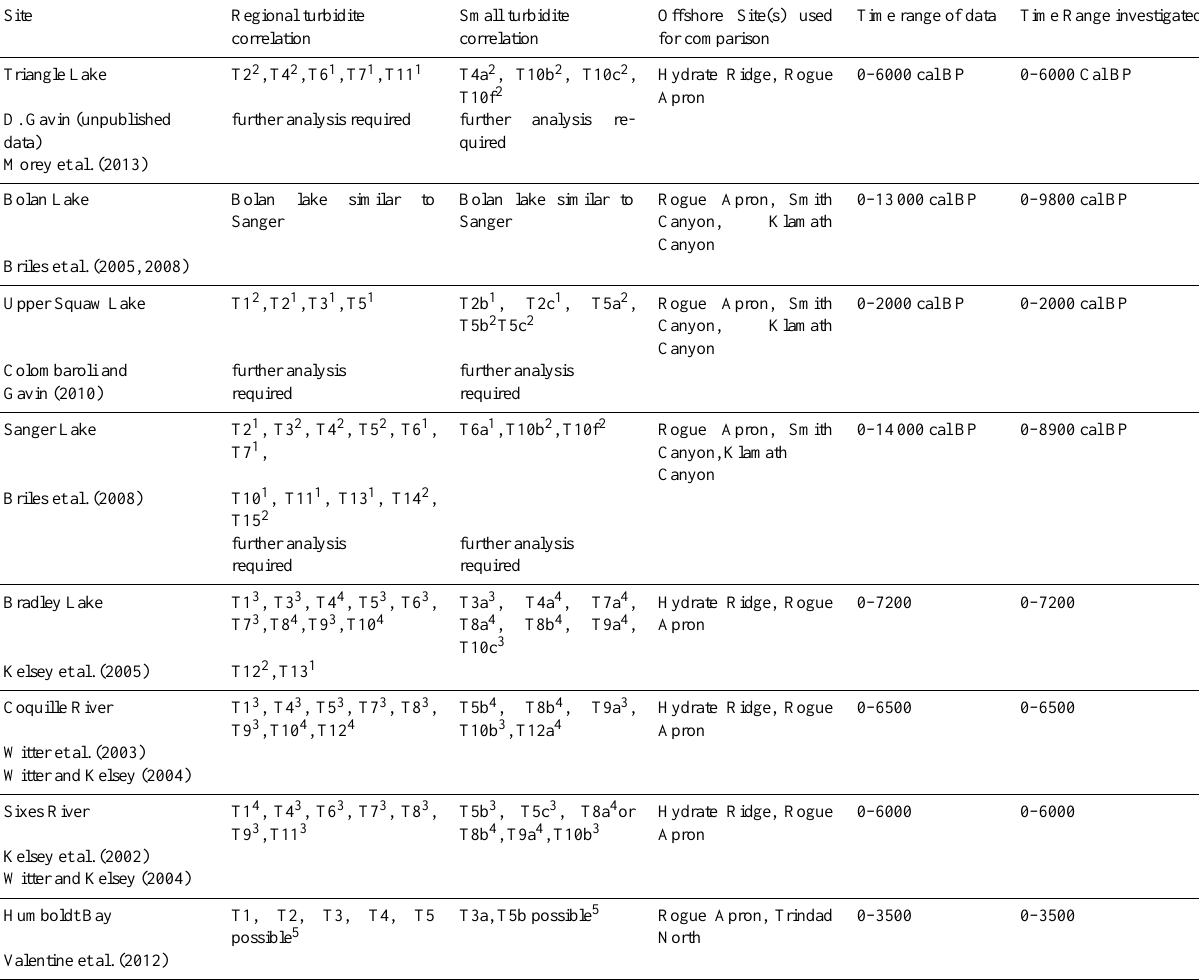
Table 4. Summary comparison of onshore paleoseismic evidence and offshore turbidite